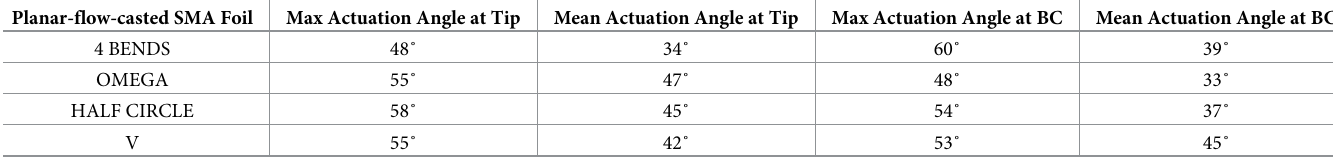
Table 2. A comprehensive summary of the maximum and mean actuation angles achieved by the four different shaped SMA foils, whereas BC is the Body Centroid of the SMA foil, and the Tip is the actuation angle at the dynamically changing tip of the body. Planar-flow-casted SMA Foil